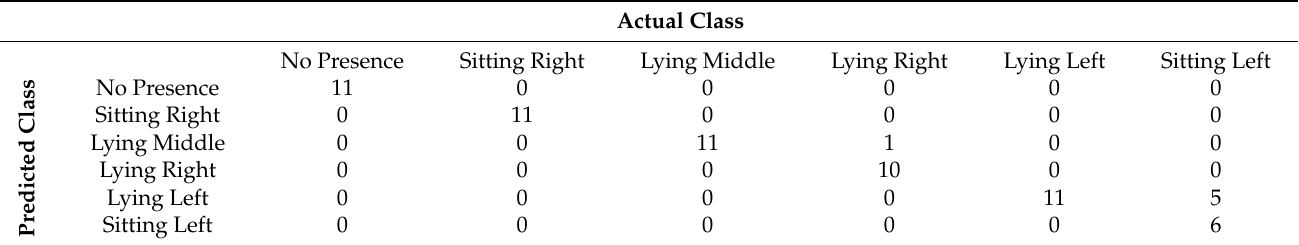
Table 5. Confusion matrix with the results of the second battery of tests. Actual Class Sitting Right Lying Middle Lying Right Lying Left Sitting Left